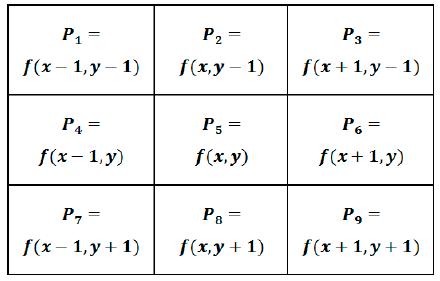
Figure 1. 3 × 3 matrix to indicate direction of the four gradients D i . Information 2017 , 8 , 104